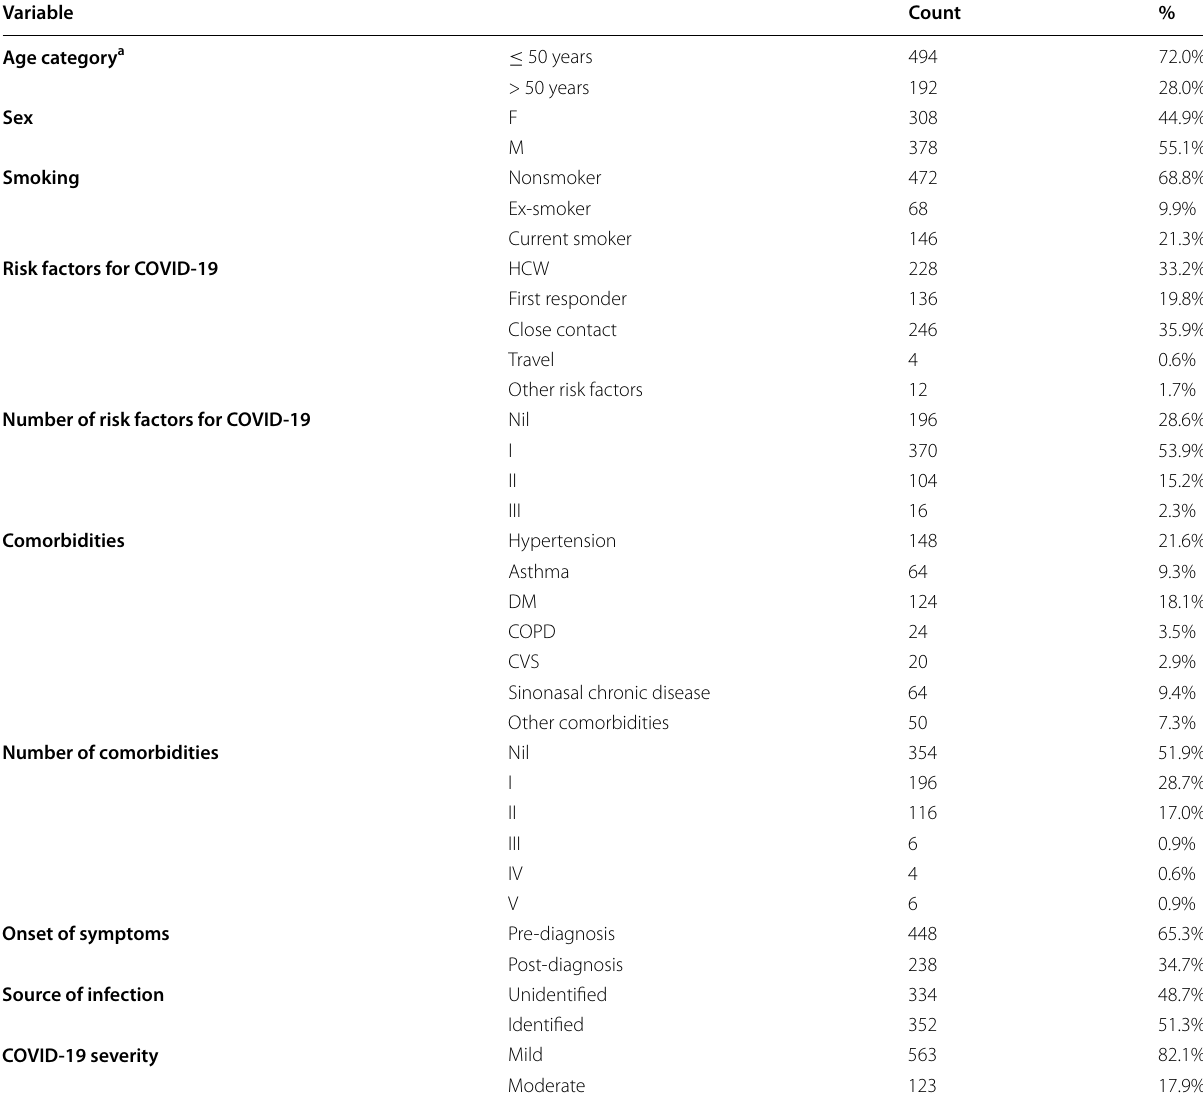
Table 1 Characteristics of the study